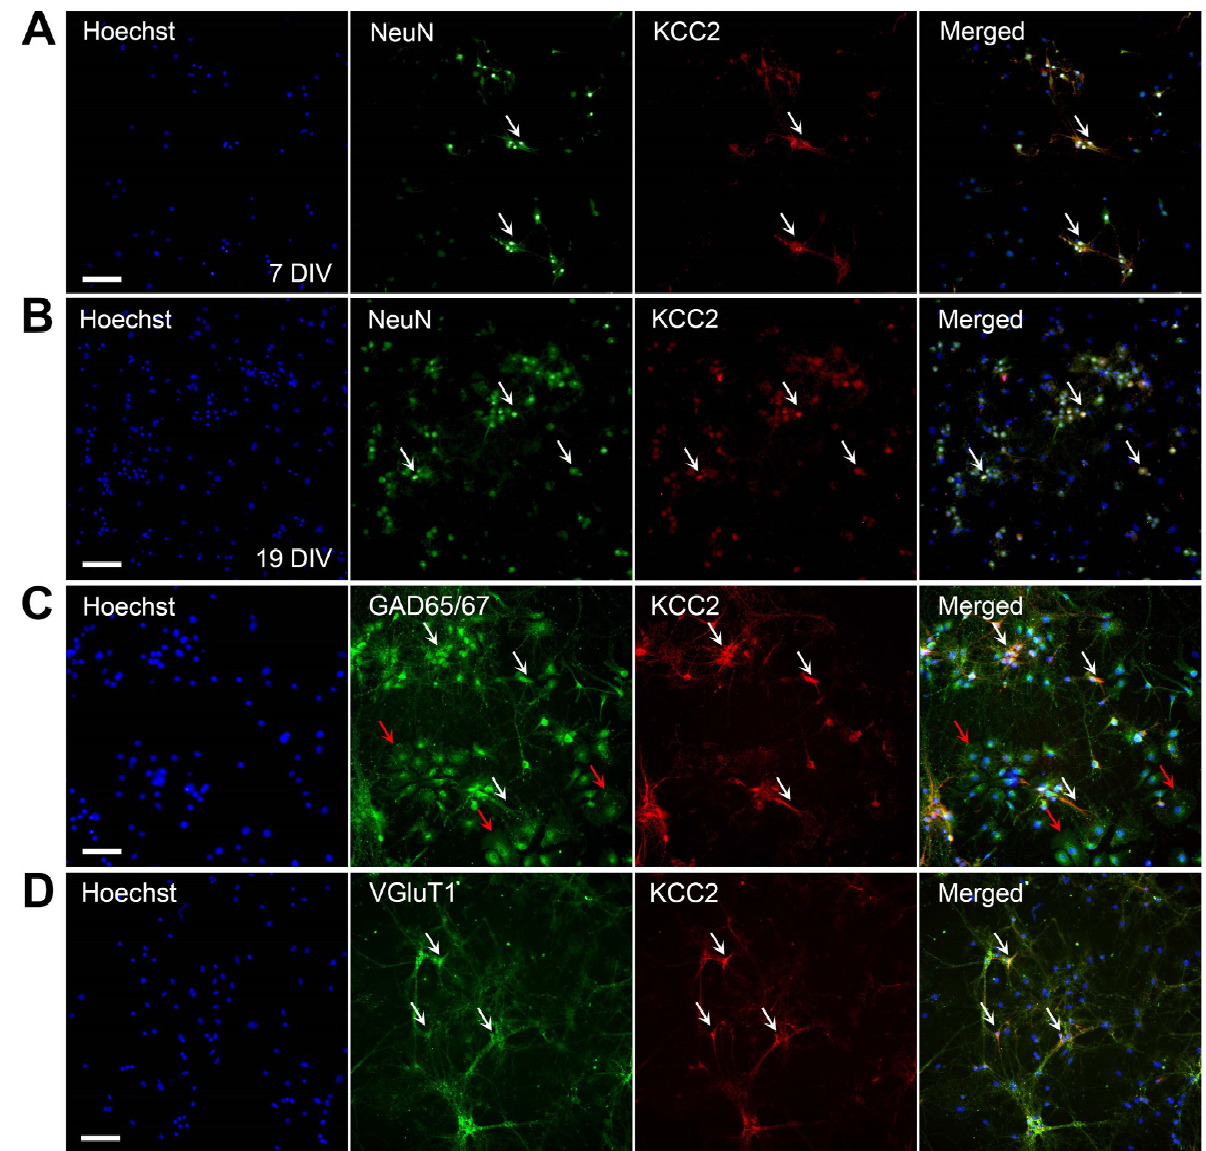
Figure 1. KCC2 is expressed by primary hippocampal neurons. ( A ) Neurons immunolabeled at 7 DIV; ( B ) Neurons immunolabeled at 19 DIV. Primary hippocampal neurons double-labeled for the neuronal marker, NeuN (green), and KCC2 (red) show neuronal expression of KCC2. White arrows indicate colocalization of KCC2 to neurons (yellow). ( C ) KCC2 expression in GABAergic neurons. Primary mouse hippocampal neurons at 7 DIV were double-labeled with the GABAergic marker, GAD65/67 (green), and KCC2 (red). White arrows indicate colocalization of KCC2 to GABAergic neurons (yellow). Red arrows indicate potential endothelial cells in culture which are void of KCC2 staining. ( D ) KCC2 expression in glutamatergic neurons. Primary mouse hippocampal neurons at 7 DIV were double-labeled with the glutamatergic marker, VGluT1 (green), and KCC2 (red). White arrows indicate colocalization of KCC2 to glutamatergic neurons (yellow). All cell nuclei are counterstained with Hoechst 33342 (blue). Scale bar = 100 µ